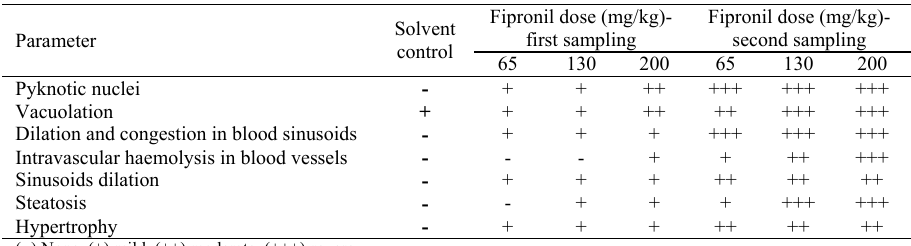
Table 5: Impact of intraperotoneal exposure to fipronil in livers of Caspian kutum for 7 and 14 days. Parameter